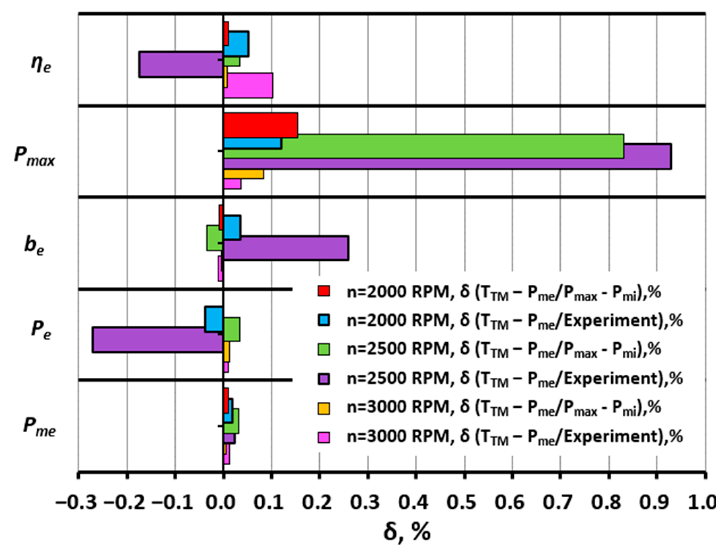
Figure 5. Comparison between simulated (according to different methodologies) engine parameters and experimental data.